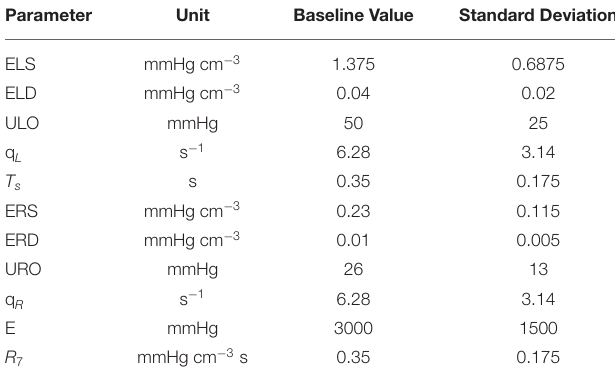
TABLE 3 | Summary of the baseline values and the SDs utilized in the EA simulation. Parameter Unit